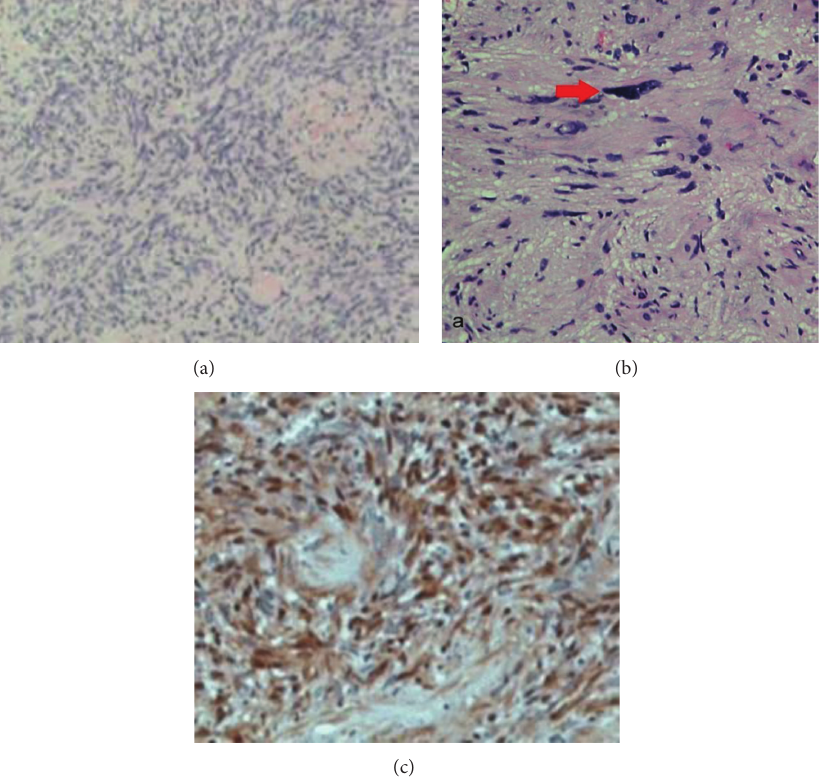
Figure 4: (a) Microscopic appearance of tumour showing Antoni A pattern with nuclear palisading (H & E staining). (b) Spindle cells in an Antoni type A area; red arrow indicates a large bizarre hyperchromatic nucleus. (c) Immunohistology slide confirming the diagnosis of